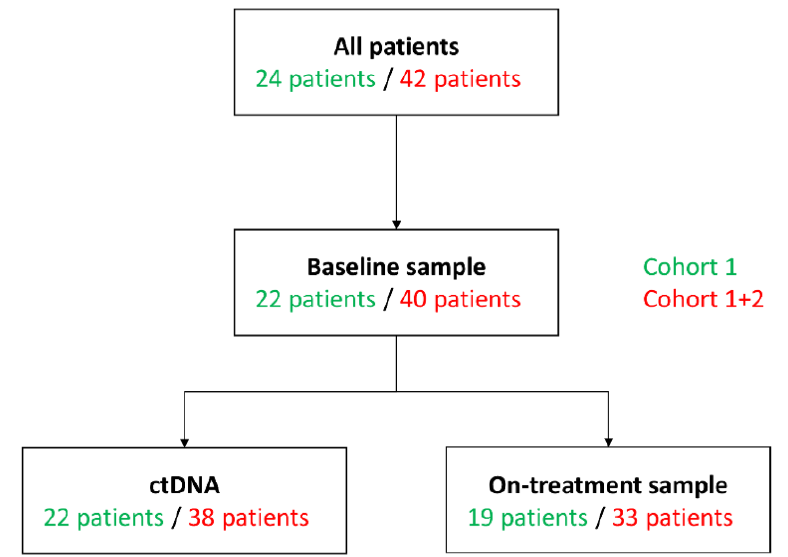
Figure 2. Overview of available